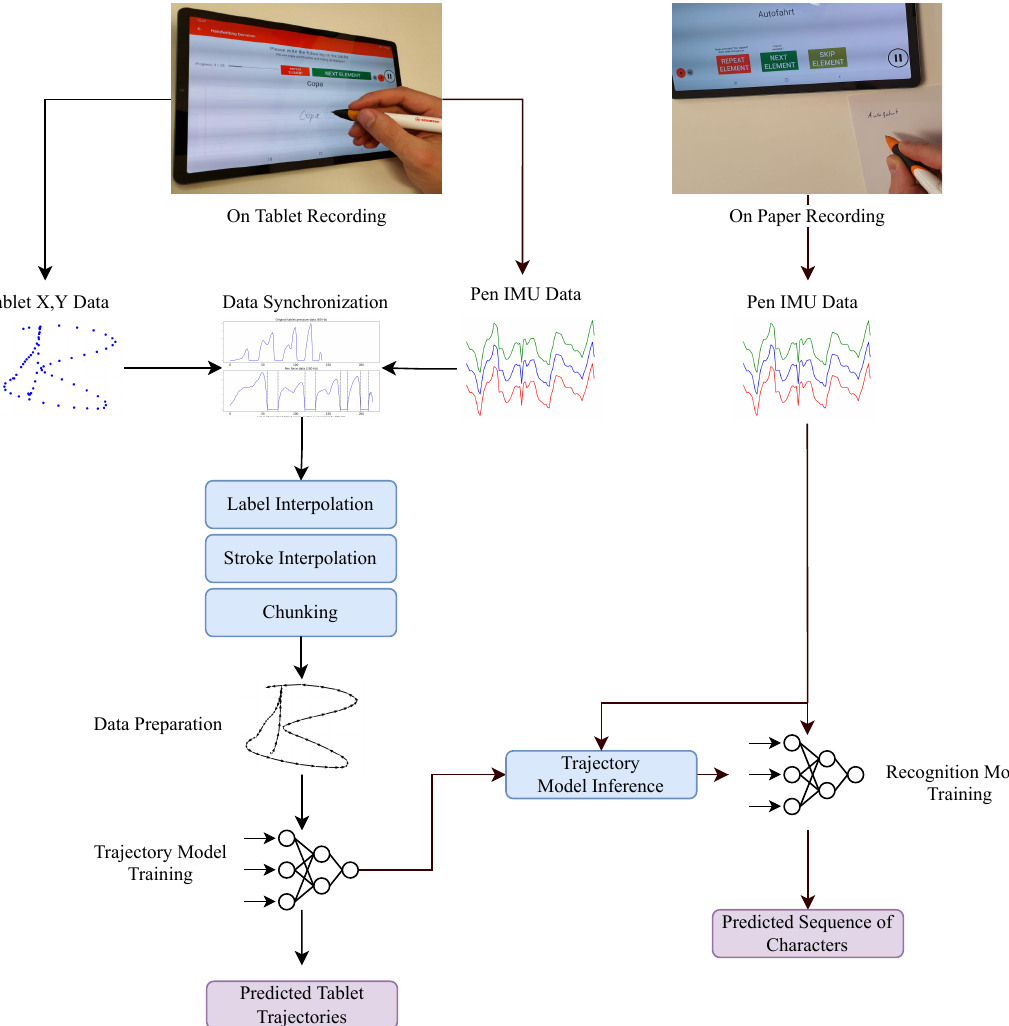
Figure 1. A visual summary of the workflow of our paper. We develop an end-to-end neural network model for handwriting trajectory reconstruction using data collected by writing with a digital pen on a tablet. The system was also tested on writing on paper by developing a text recognition model using IMU data and the relative generated trajectory